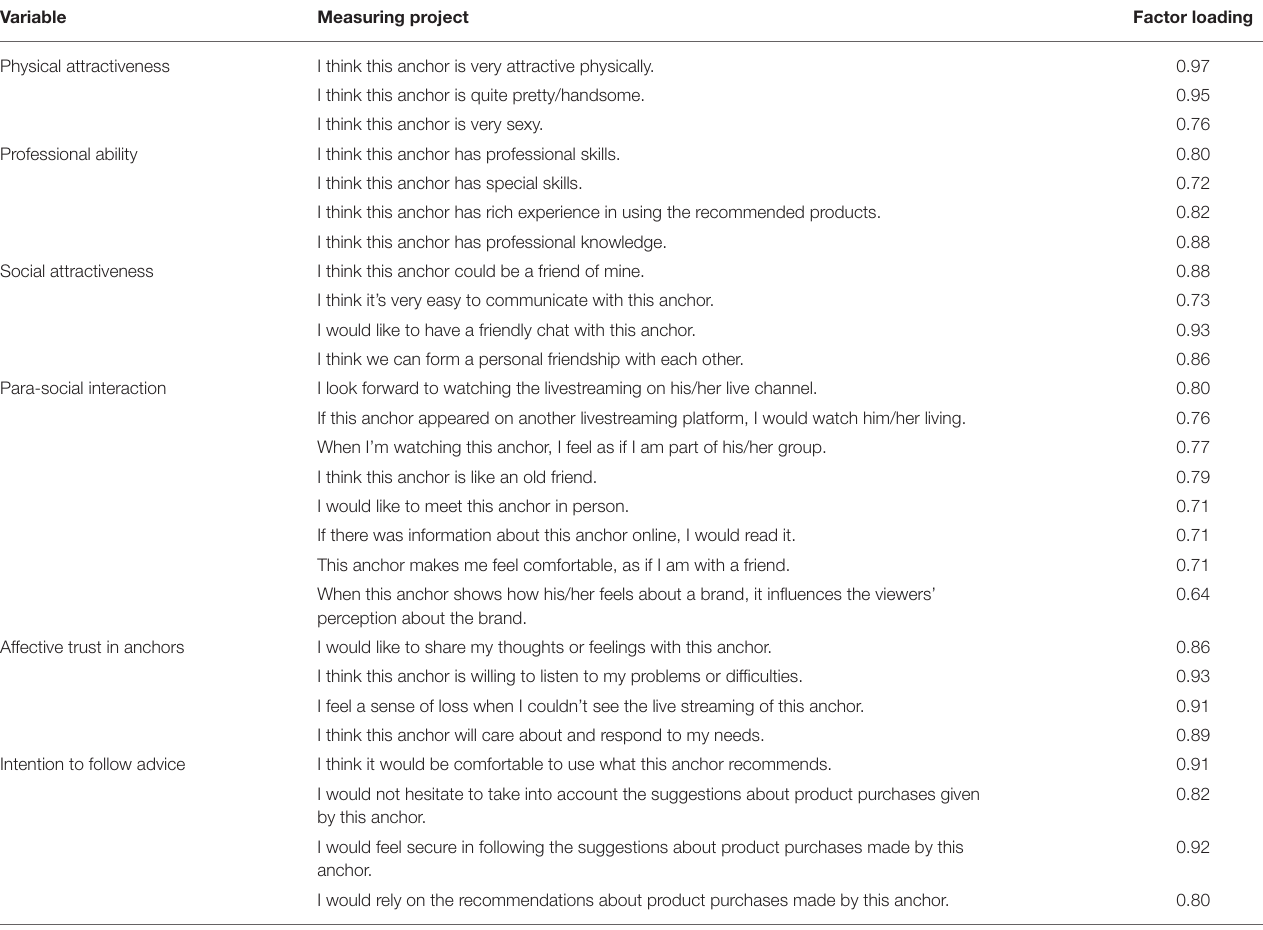
TABLE 1 | Variable measurement scale. Variable Measuring project Physical